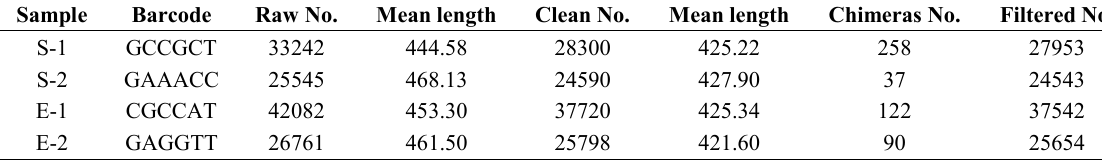
Table 4. Bacterial Alpha diversity index statistics.